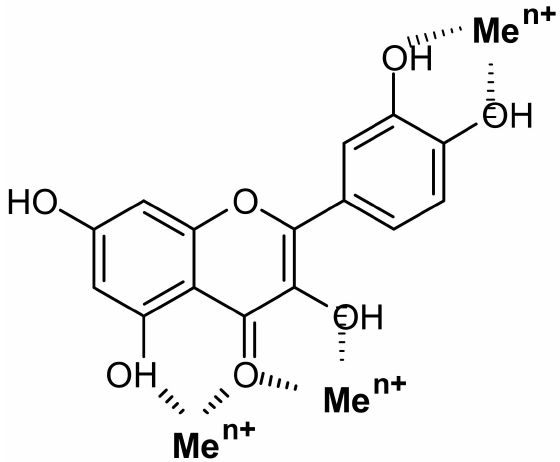
Figure 3. Possible binding sites of quercetin according to